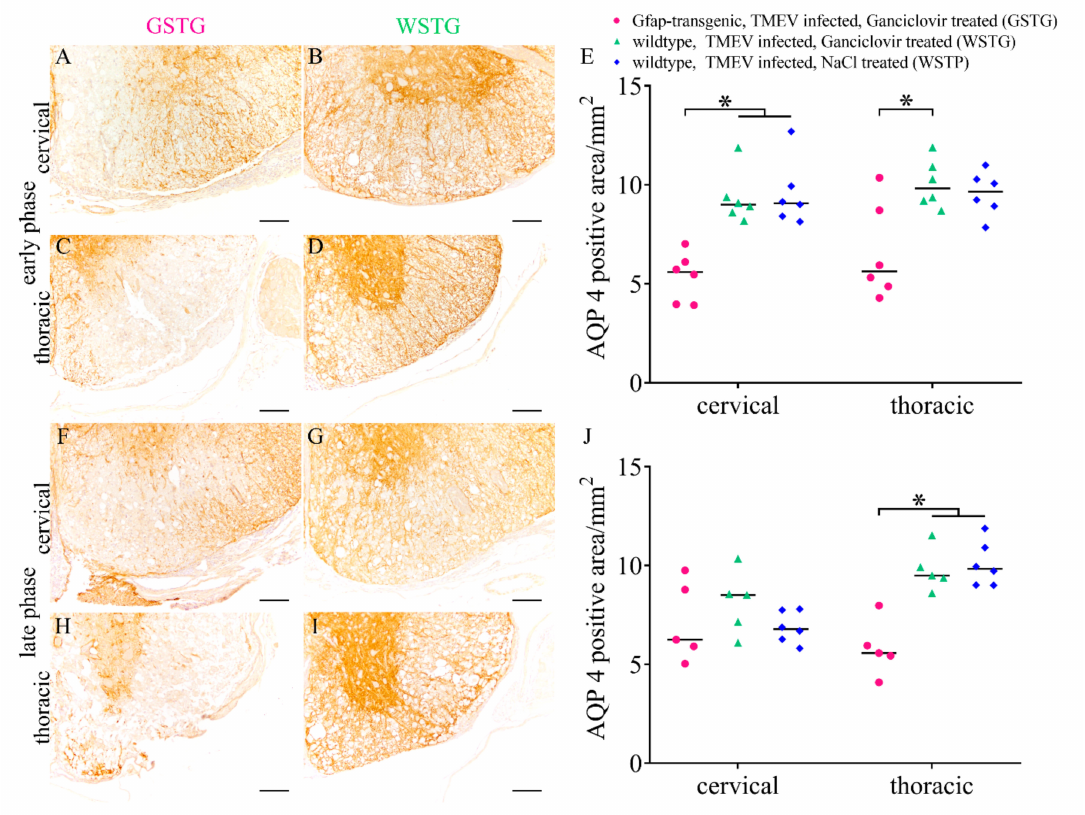
Figure 4. Impact of astrocyte depletion upon aquaporin 4 (AQP4) expression. Immunohistochemistry targeting AQP4 revealed a significant reduction of AQP4 positive area in the cervical and thoracic spinal cord segment of TMEV infected, ganciclovir treated, Gfap -transgenic mice (GSTG) mice at 46 days post infection (dpi; early phase; A – E ). At 77 dpi (late phase), GSTG mice showed a significant reduction of AQP4 positive area in the thoracic spinal cord ( F – J ). Data are shown as scatter dot plots. Significant di ff erences between the groups obtained by Kruskal-Wallis test followed by Mann–Whitney U post hoc tests were indicated by *, p < 0.05. Bars represent 100 µ